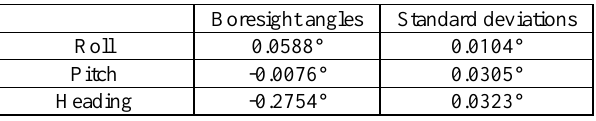
Table 12: Results from Test #1